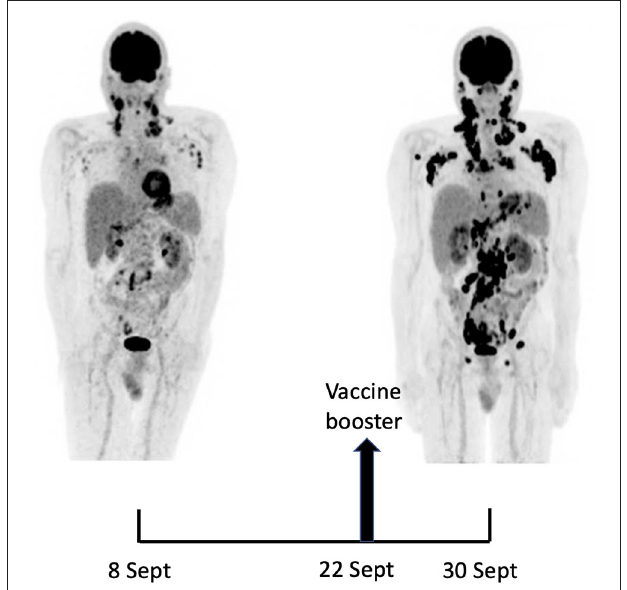
FIGURE 1 | Maximum-intensity-projection images of 18 F-FDG PET/CT at baseline (8 Sept) and 22 days later (30 Sept), 8 days after BNT162b2 mRNA vaccine injection in right deltoid. 8 Sept: hypermetabolic lymph nodes mainly in the supra-clavicular, cervical, and left axillary regions; restricted gastro-intestinal hypermetabolic lesions. 30 Sept: Dramatic increase in nodal and gastro-intestinal hypermetabolic lesions. Asymmetrical metabolic progression in the cervical, supra-clavicular and axillary area, more pronounced on the right